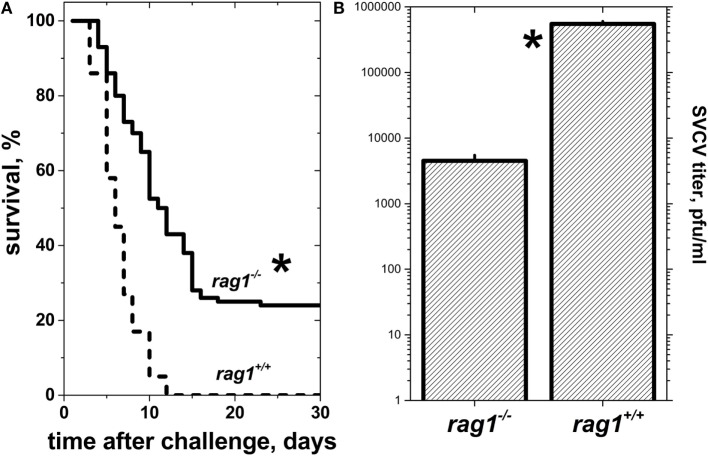
Naïve adult rag1−/− zebra fish are more resistant to lethal spring viremia carp virus (SVCV) infection than rag1+/+ zebra fish. (A) Kaplan–Meier survival curves of naïve rag1−/− (n = 84) and rag+/+ (n = 100) adult zebra fish after exposure to a lethal dose of 104 pfu/ml of SVCV under the same challenge conditions as in panel (A). *Statistically significant differences between survival curves between rag1−/− and rag+/+ as determined by the Gehan–Breslow–Wilcoxon test with p < 0.05 (n = 2). Solid lines, rag1−/− zebra fish larvae. Dashed lines, rag+/+ zebra fish larvae. (B) SVCV titers from pooled whole zebra fish (n = 4 zebra fish per genotype) 3 days after SVCV infection as determined by plaque forming unit (pfu) assays.